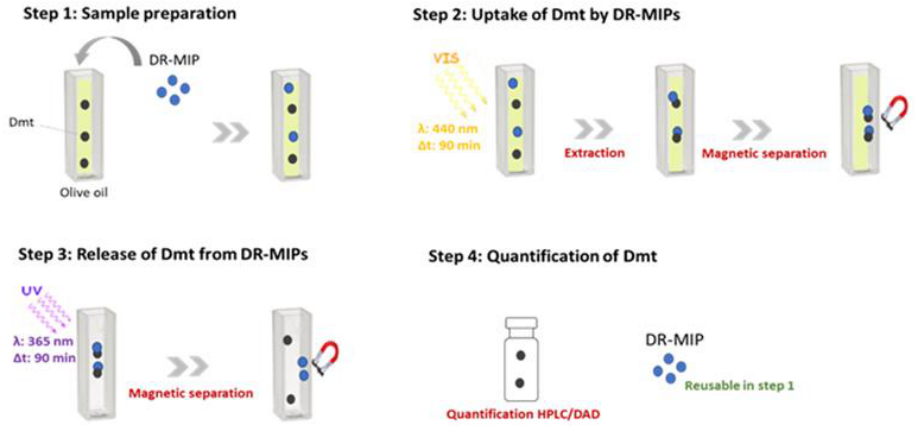
Figure 1. Schematic representation of the analytical methodology for the trace analysis of dimethoate (Dmt) in olive oil samples using core-shell magnetic-photonic molecularly imprinted polymer nanoparticle (DR-MIP) as sorbent.